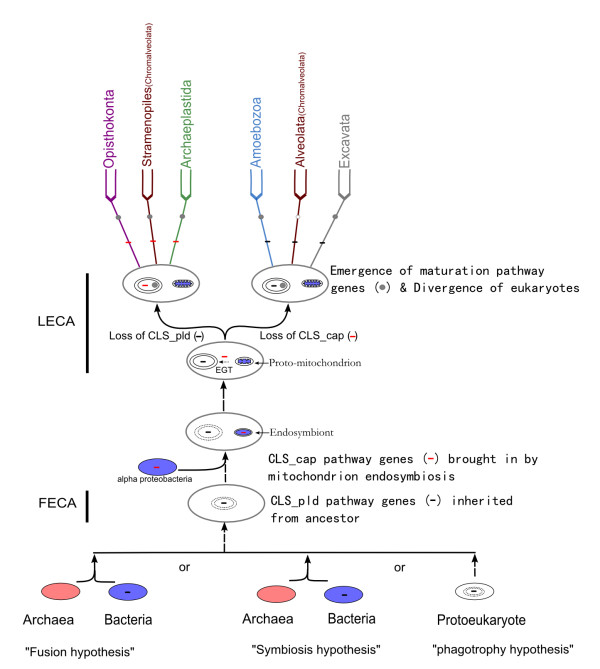
An evolutionary route chart of CL biosynthesis and maturation pathways in eukaryotes. Short black bar, CLS_cap gene; Short red bar, CLS_pld gene; Grey dot, CL maturation pathway genes; Hollow dot, absence of CL maturation pathway. EGT, endosymbiotic gene transfer from proto-mitochondrion to nucleus.